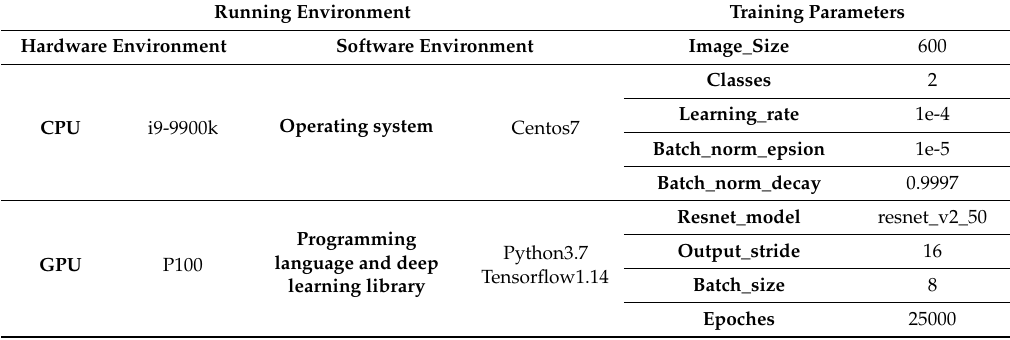
Table 3. Network operation environment and training